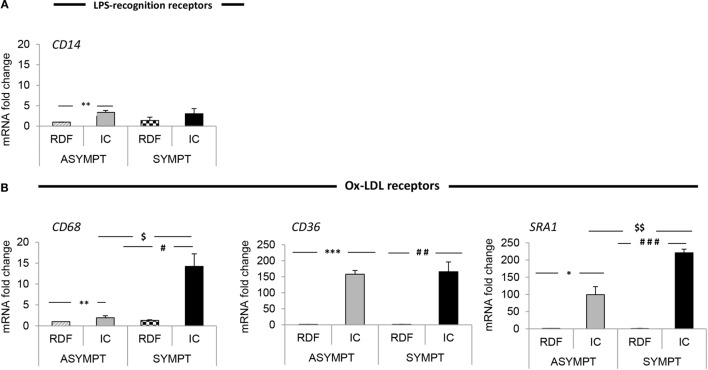
Macrophage polarization marker mRNA analysis in symptomatic vs. asymptomatic patients. The panels display mRNA fold change expression of 22 macrophage markers over control (RDF in asymptomatic patients). RT-PCR analysis showed that (A) in both asymptomatic and symptomatic plaques low level of the LPS-recognition receptor, CD14 is expressed. In symptomatic plaques the macrophage profile is characterized by increased expression of (B) ox-LDL scavenger receptors (CD68, CD36, and SRA-1), Th1-associated (C) chemokines (CXCL10 and MCP-1) and (D) cytokines (TNFα, IL-1β, IL-6, IL-8, IL-12p40, and IL-12p35) and (I) efflux proteins (ABCA1 and ABCG1), compared with asymptomatic patients, suggesting a predominant MΦ1 phenotype among the whole macrophage population. Conversely, asymptomatic lesions are primarily composed of MΦ2-like macrophages, characterized by increased expression of Th2-associated (E) chemokines (CCL22 and CCL18) and (F) cytokines (IL-10, IL-4, and IL-13), (G) Hb–Hp scavenger receptor (CD163) and (H) polysaccharide receptors (Dectin 1, MR) compared to symptomatic plaques. Data are mean ± SEM where * # £ $p < 0.05, ** ## ££ $$p < 0.01, *** ### £££ $$$p < 0.001 vs. controls, after T-test analysis of N = 3 independent experiments. Controls legend: * indicates comparison between RDF vs. IC in asymptomatic; # indicates comparison between RDF vs. IC in symptomatic; £ indicates comparison between RDFs in the two subgroups of patients;$ indicates comparison between ICs in the two subgroups of patients.